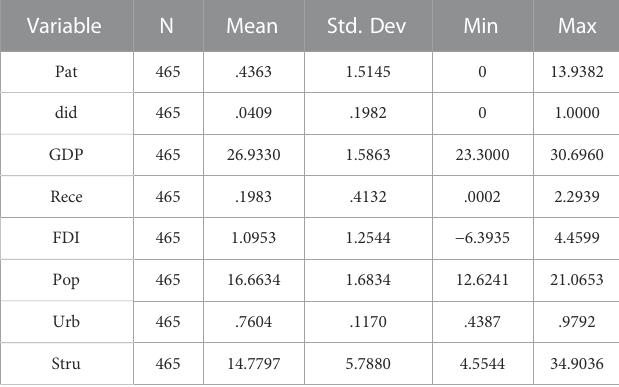
TABLE 3 Descriptive statistical results for the variables.